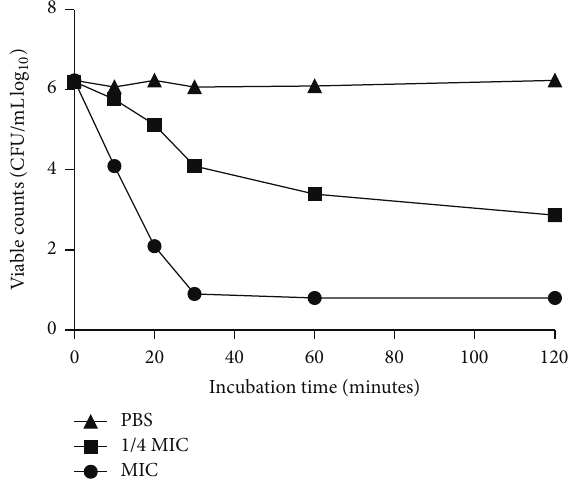
Figure 2: Bactericidal kinetics of Mdc against A. baumannii GIM1.650 after incubation with different concentration of Mdc. A 5-log reduction occurs after 30 min at the MIC (4 𝜇 g/mL). The experiment was carried out in triplicate, and average values are reported (SD ⩽ 10